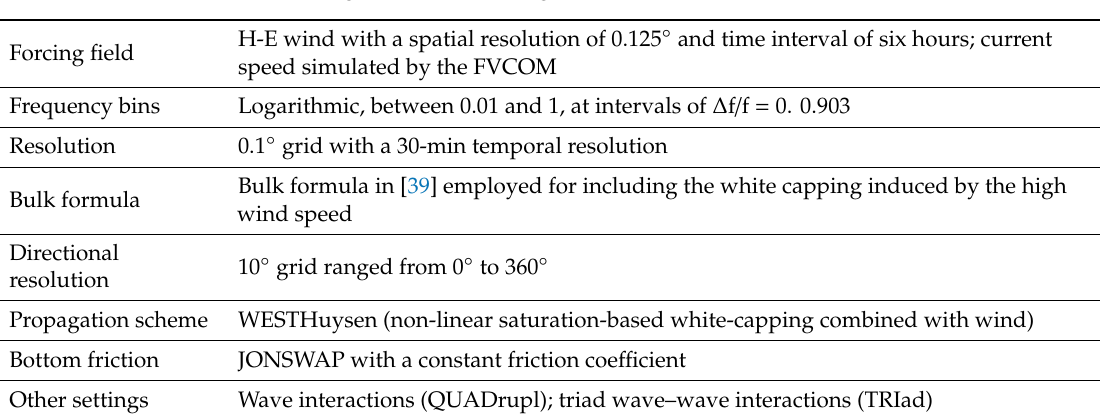
Table 2. Settings for the Simulating Waves Nearshore (SWAN)